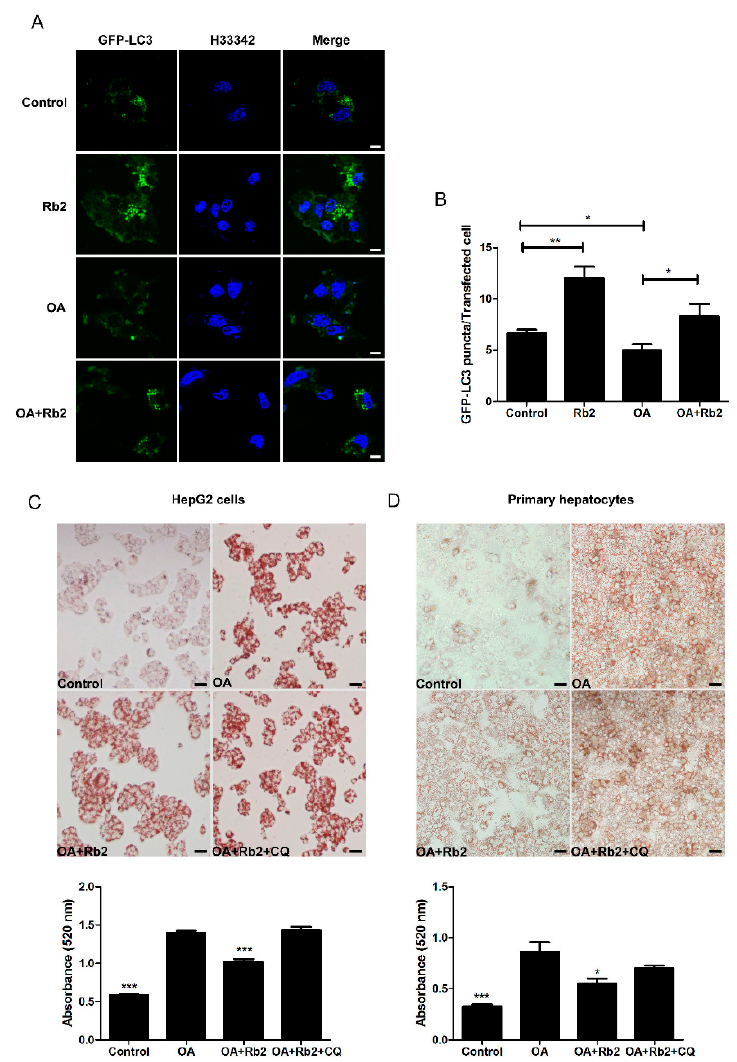
Figure 6. Rb2 suppressed high fatty acid in combination with high glucose (OA-induced hepatosteatosis via the upregulation of autophagy. The effect of OA with and without Rb2 on GFP-LC3 punctas formation in HepG2 cells were monitored by fluorescence confocal microscopy ( A , Scale bars = 5 µm), and the amount of GFP-LC3 punctas per transfected cell was quantified ( B ). * p < 0.05 and ** p < 0.01 compared with indicated two groups. HepG2 cells ( C ) and primary mouse hepatocytes ( D ) were pretreated with 50 µmol/L Rb2, with or without CQ (25 µmol/L) for 4 h before OA (1 mmol/L for HepG2 and 2 mmol/L for primary mouse hepatocytes) exposure for 12 h, and lipid accumulation were visualized (Scale bars = 20 µm) and quantified by oil red O (ORO) staining. Data are expressed as mean ± SE from three independent experiments. * p < 0.05, ** p < 0.01, and *** p < 0.001 compared with the group that was pretreated with vehicle (Control) prior to OA exposure.